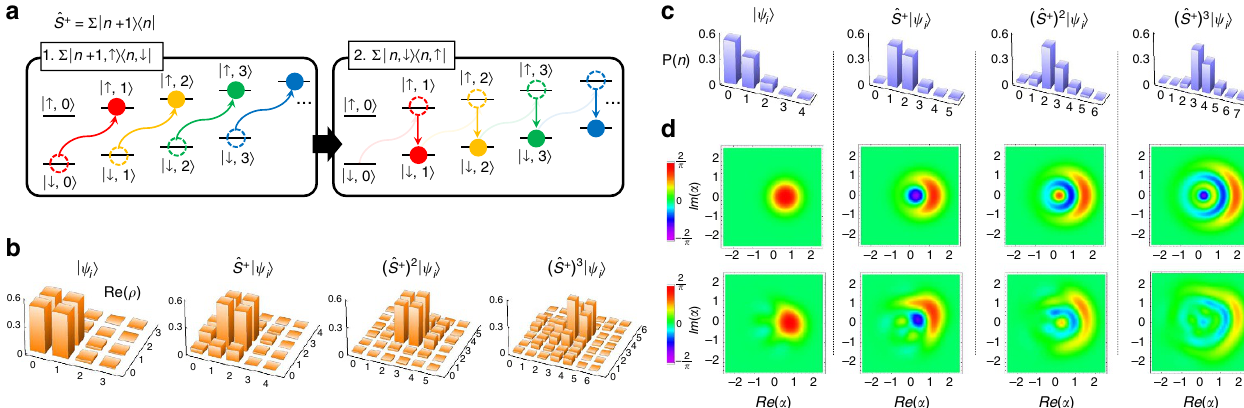
blue-sideband transition P " ; n þ 1 j